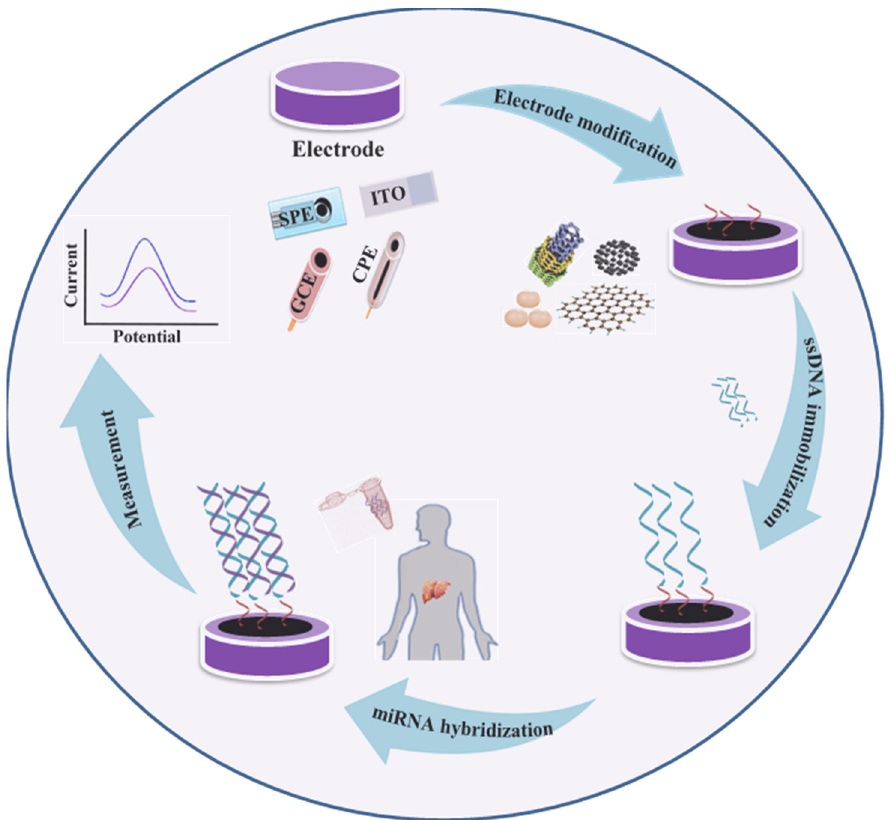
Figure 2. Schematic of various steps of miRNA biosensor fabrication including: surface functional- ization of electrodes such as screen printed electrode (SPE), glassy carbon electrode (GCE), carbon paste electrode (CPE), or indium tin oxide electrode (ITO); immobilization of ss-DNA and further hybridization with complementary miRNA; and signal analysis through electrochemical methods (differential pulse voltammetry (DPV), cyclic voltammetry (CV), Chronoamperometry, and electro- chemical impedance spectroscopy (EIS)).